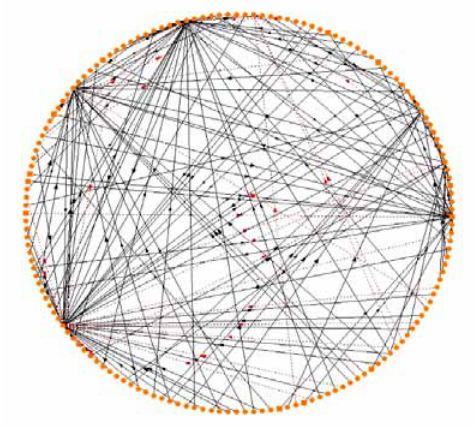
Fig. 2. Relationships between